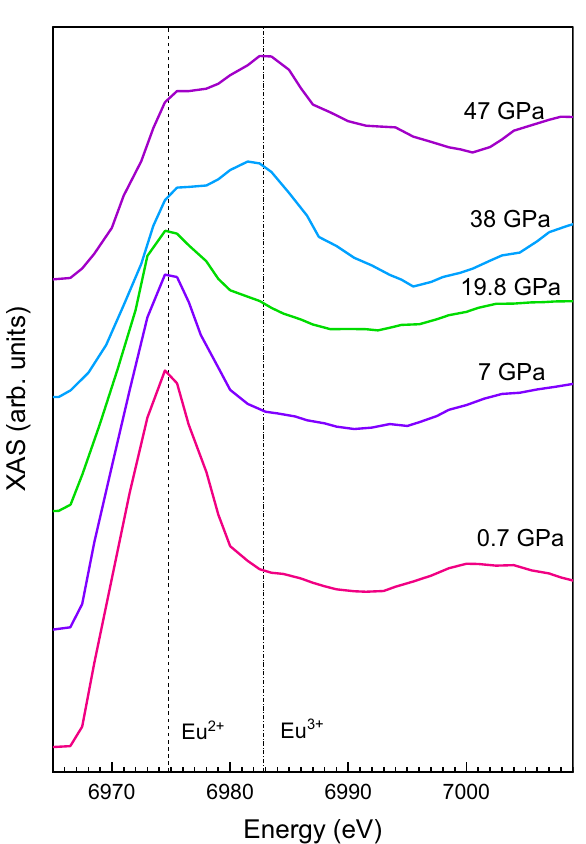
Fig. 6 Pressure-induced valence transition. PFY-XAS at Eu L 3 edge under pressure up to 47 GPa showing transition from Eu 2 + toward Eu 3 + . The two vertical dash lines indicate the absorption peak energy for Eu 2 + and Eu 3 + , respectively, with Eu 3 + located at 8 eV higher than Eu 2 + .